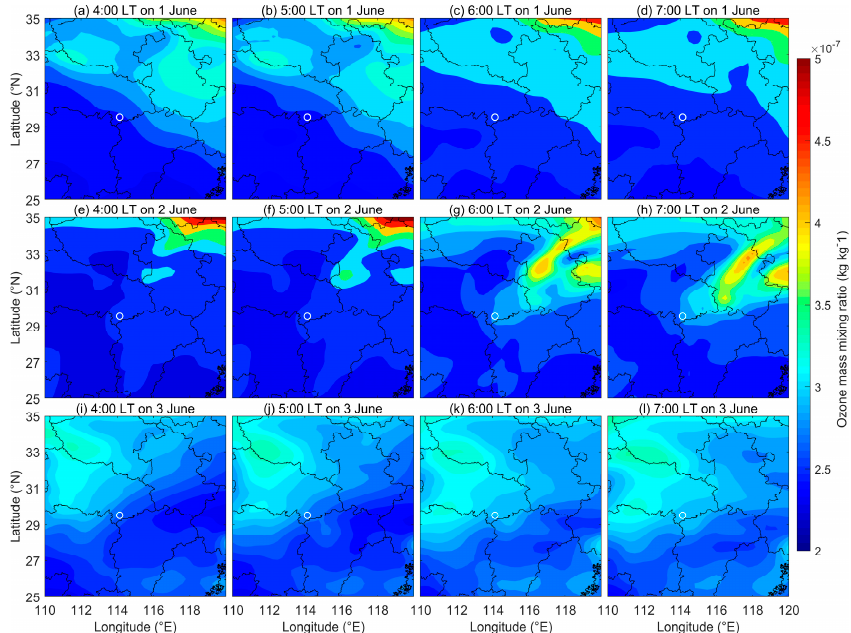
Figure 12. Ozone mass mixing ratio change at the 100 hPa level over central China (ERA 5 data). The data at 4:00 − 7:00 LT are listed from left to right in columns, and the data on 1 − 3 June 2015 are listed from top to bottom in rows. The white circle presents the location of the Wuhan MST radar.